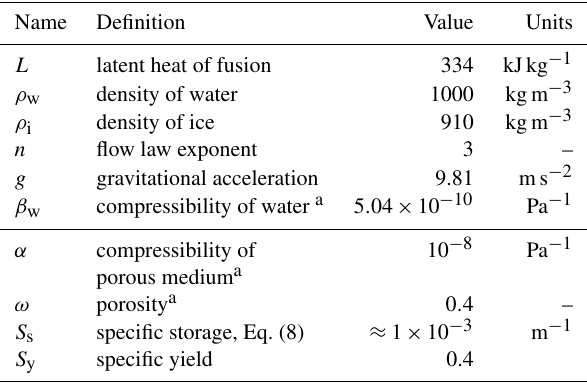
Figure 2. Experiments with artificial geometries. Vertical lines de- note moulin positions for SHMIP/B2. The orange line shows the modified bedrock used to illustrate the impact of the confined– unconfined scheme as discussed in Sect. 3.2 Table 1. Physical constants used in the model. We distinguish be- tween well known (upper half) and estimated or uncertain (lower half) parameters.